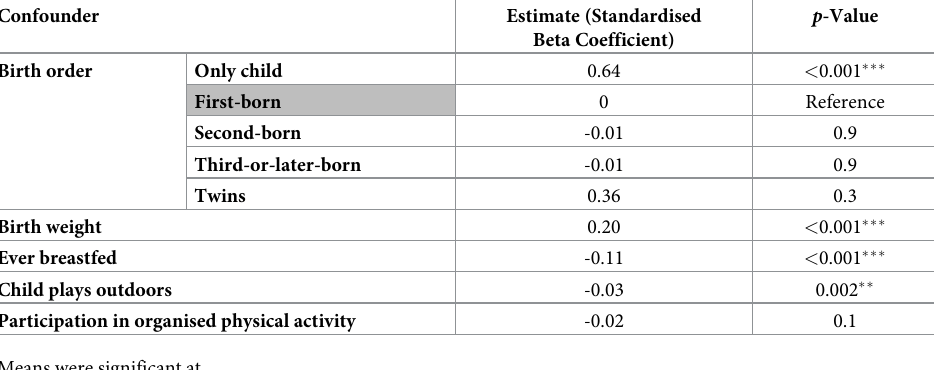
Table 5. Multivariate analysis of the effect size order of postnatal risk factors on